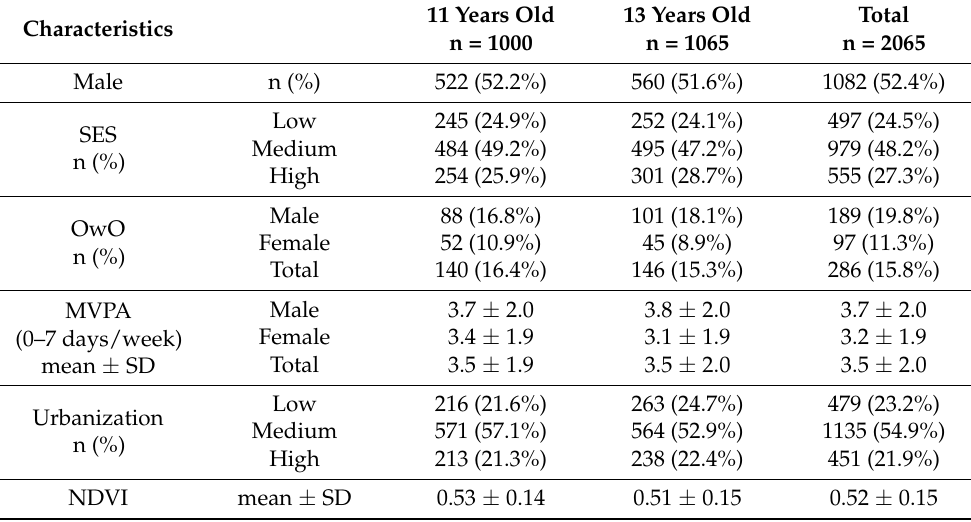
Table 1. Individual and environmental data by age